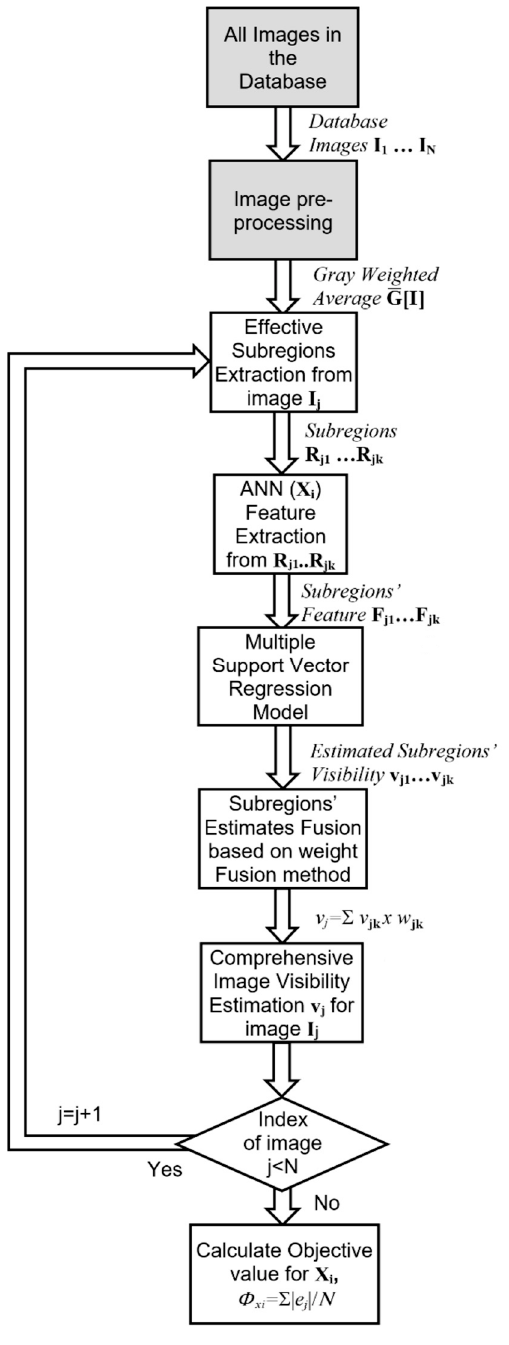
Figure 2. Particle X i Evaluation